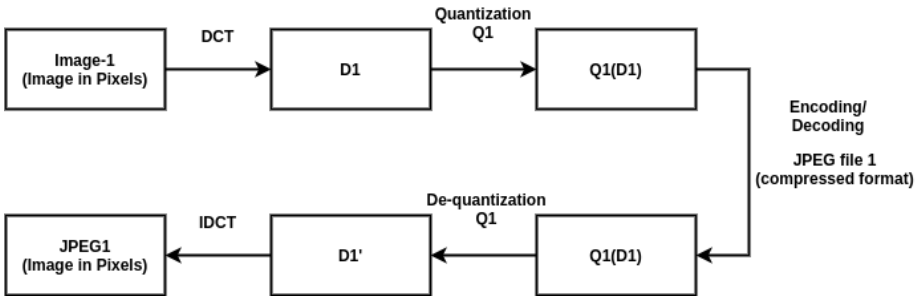
Figure 3. JPEG compression on image pixels, first DCT is applied on the image pixel blocks fol- lowed by the quantization. Then decompression of the compressed image is done with through de-quantization followed by IDCT, to obtain the image in pixel